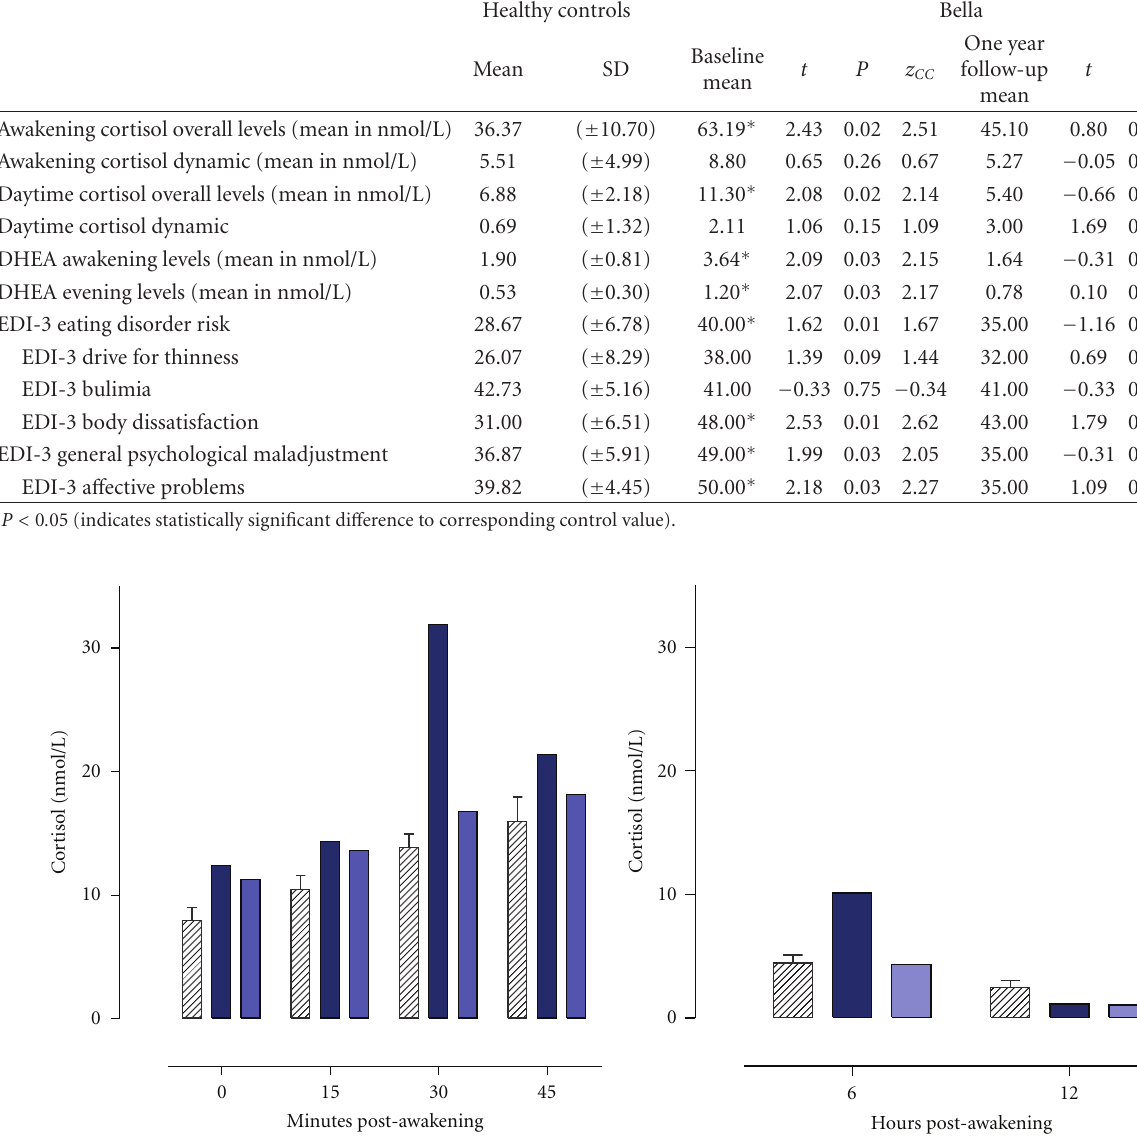
Table 1: Healthy control group ( n = 15) compared to case study Bella at baseline and when recovered at one year follow-up. Healthy controls Bella